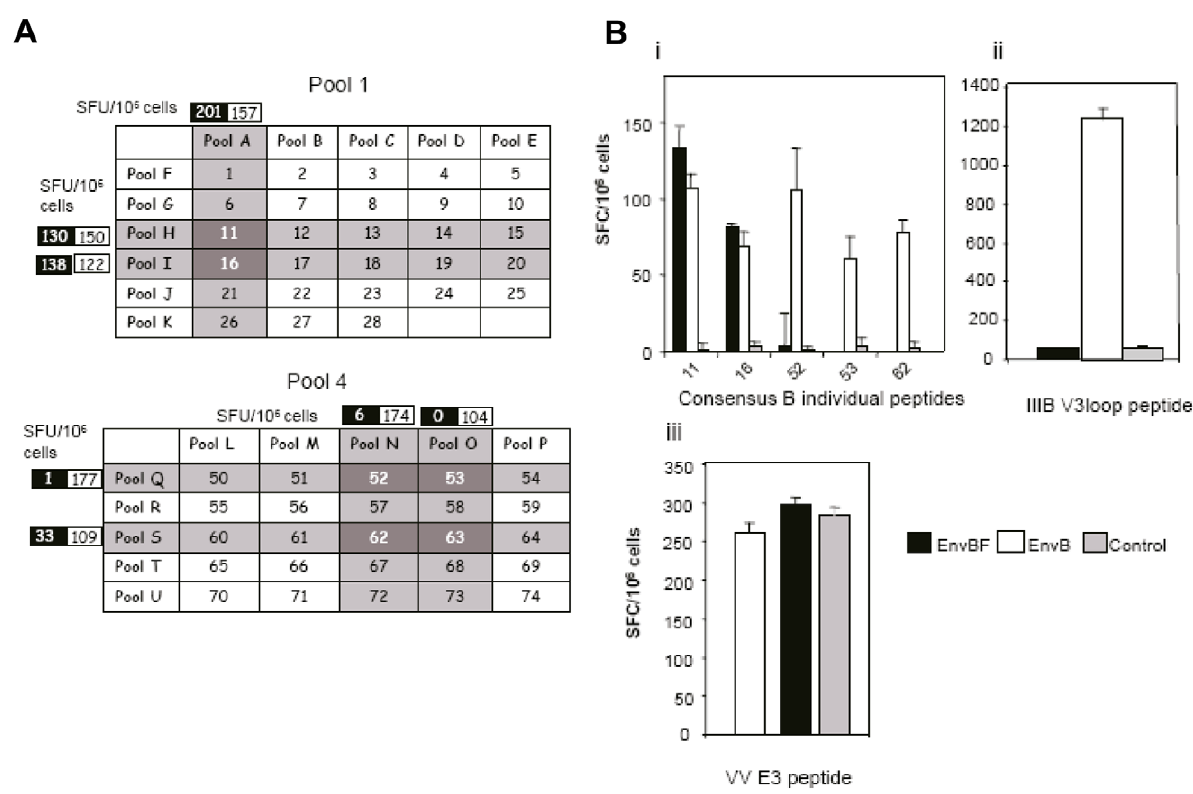
Figure 3. Mapping the gp160B specific response. A ) Matrix-peptide based analysis for poo1 and pool 4 corresponding to the constant C1 and C2 regions of gp160 EnvB protein. Number of SFU/10 6 cells found in EnvBF and EnvB immunized mice are indicated in black and white boxes respectively, and results found in reactive pools are shown. B ) Reactive peptides identified in A were evaluated in experiments in which single individual EnvB peptides were employed in the ELISPOT assays. Figure shows magnitude of the responses detected against consensus B identified peptides (i), the IIIB CD8 + V3 loop peptide (ii), and the VV CD8 + E3 peptide (iii). Results are representative of three independent experiments. doi:10.1371/journal.pone.0017185.g003 Fig. 5B describes the sequence analysis of the peptides targeted, immunogenicity (iii). For the first instance (i), it can be seen that in highlighting the aa changes that permit cross-reactivity (i), that the case of peptide 11 no aa changes occurred between both confer subtype specificity (ii) and those that ablate or diminish sequences (envB and envBF), or as it occurred for peptide 13BF